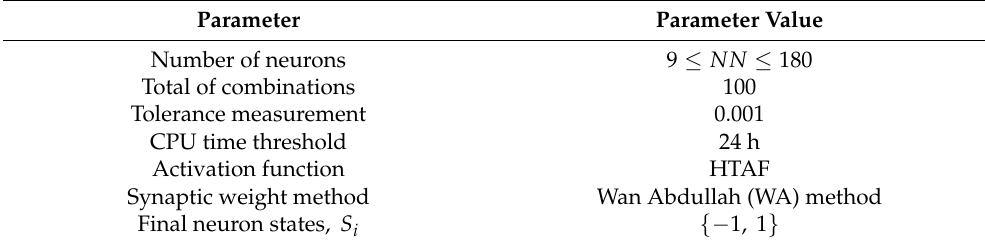
Table 1. Listing of related parameters in the HNN-3SAT.